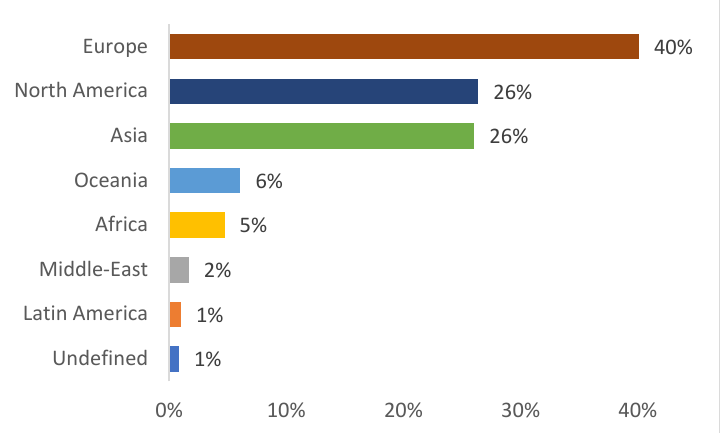
Figure 2. Share of geographical distribution of the paper published on the weeds–mycorrhiza interaction from 1975 to September 2022.